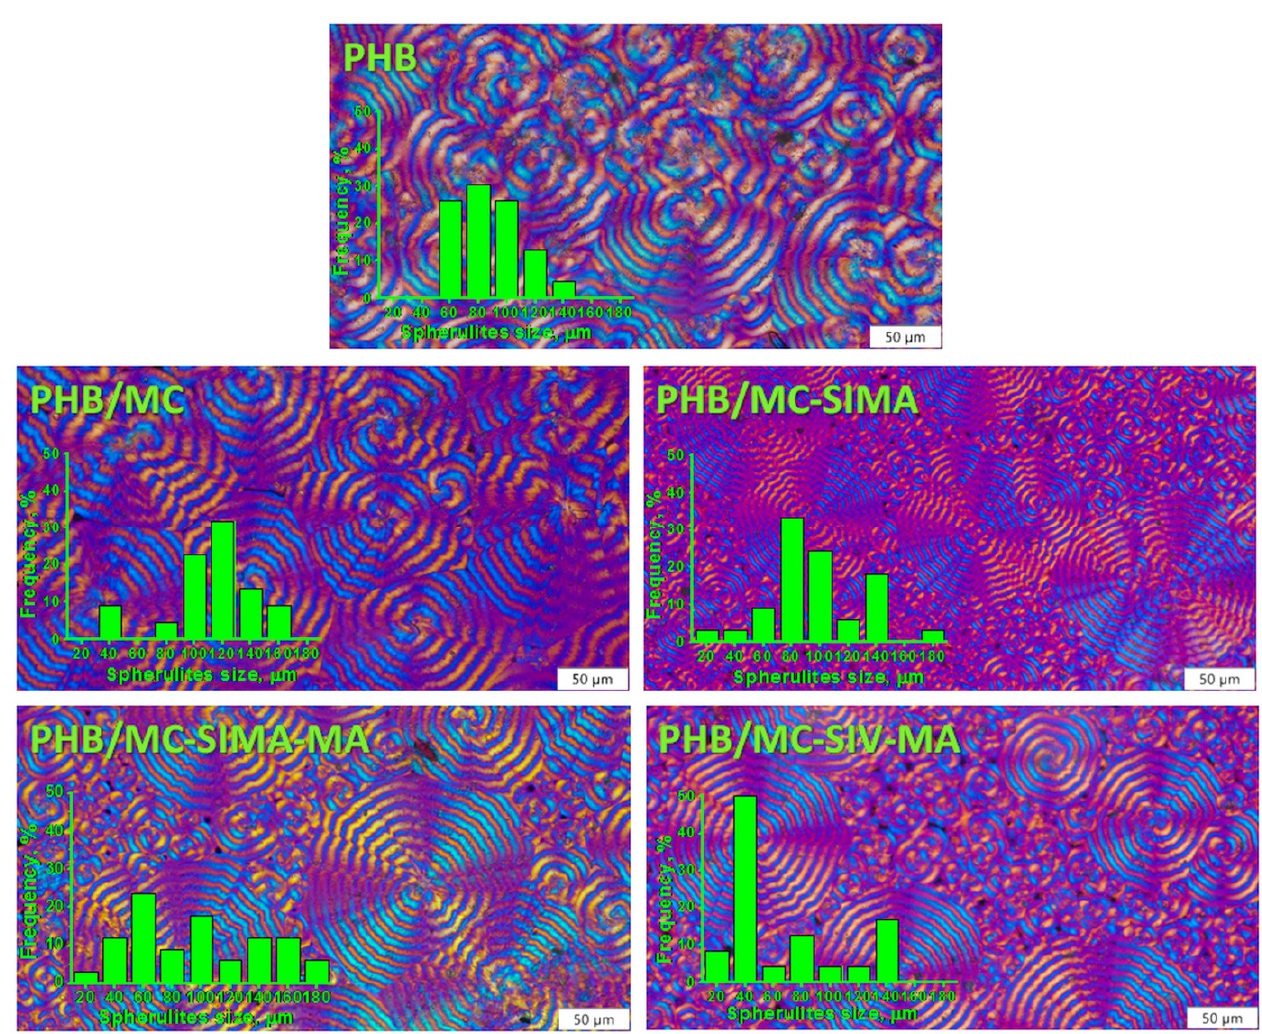
Figure 7. Polarized optical micrographs of PHB and composites with differently modified celluloses (×40); scale bar 50 µm .